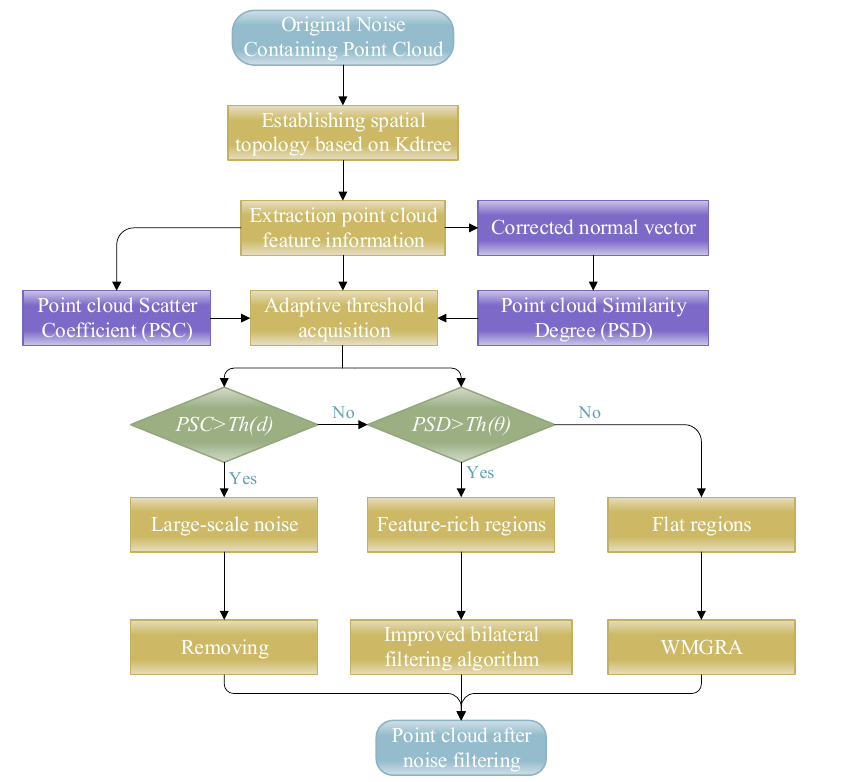
Figure 3. Flow chart of fast adaptive multi-scale noise filtering algorithm.